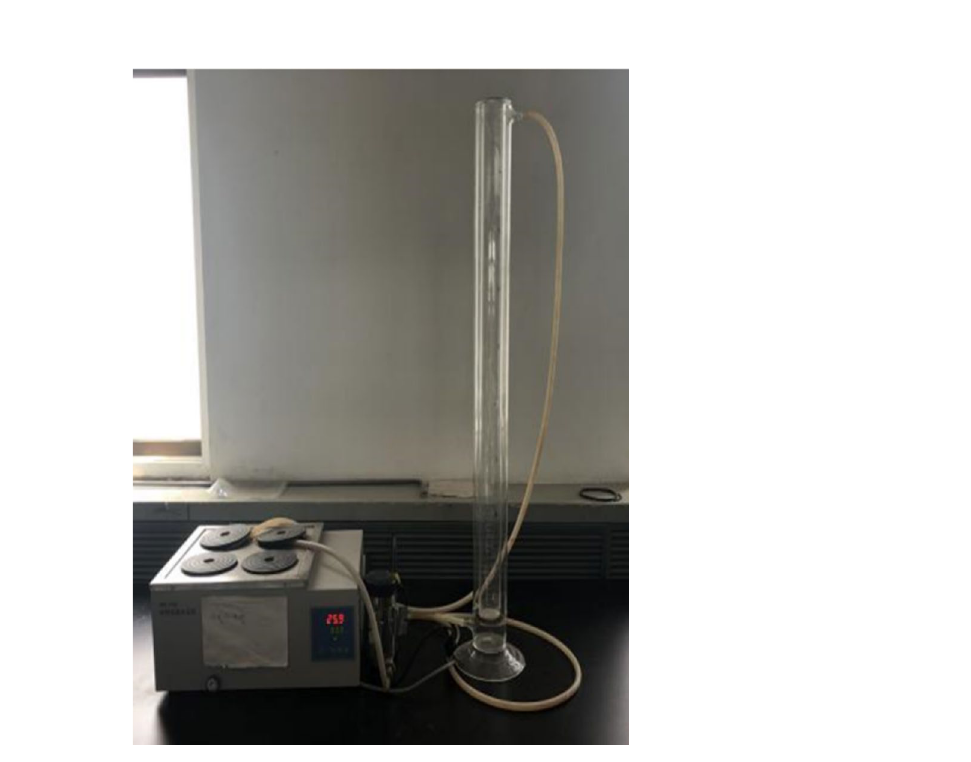
Figure 6. 1-L graduated cylinder for measuring the settling rate of proppants with a temperature